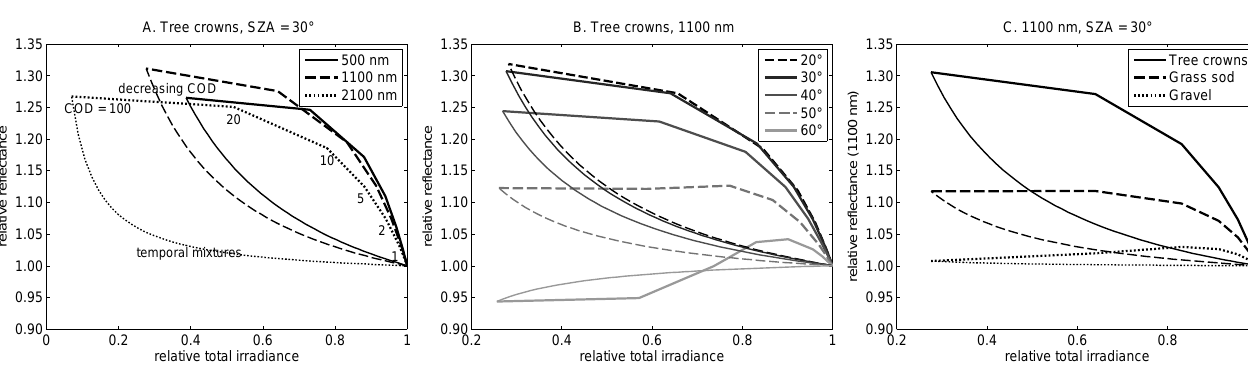
Figure 5. Relative reflectance compared to clear sky reflectance simulated with pbrt and SBDart for gradually increasing cloud optical depth (thick curves) and different mixtures between clear and obscured conditions (thin curves). Simulations for (a) three different wavelengths, (b) five solar zenith angles and (c) three surface